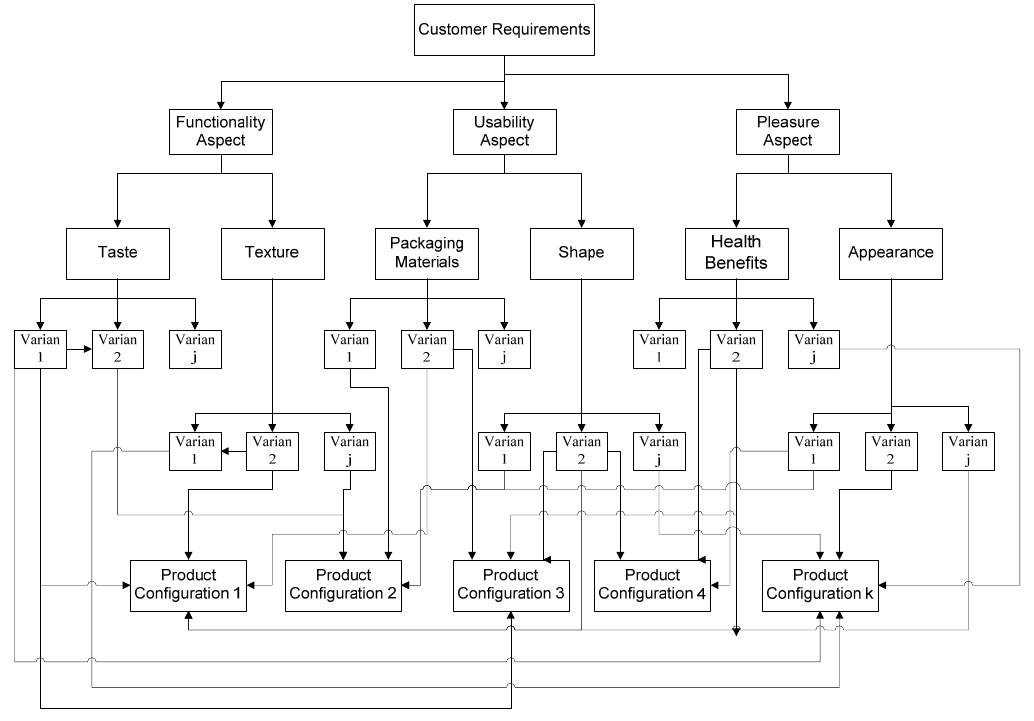
Figure 1. Product Figure 1. Product configurations.